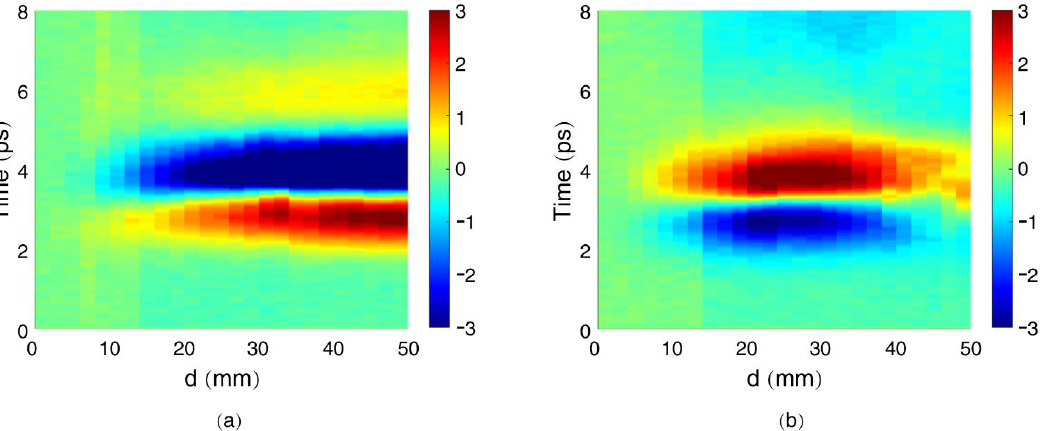
Figure 5. Measured THz radiation from a dc-biased filament with a longitudinal external electric field along the filament: ( a ) horizontally polarized component ( 𝐸 𝑥𝑙𝑜𝑤𝑒𝑟 ); ( b ) vertically polarized com- ponent ( 𝐸 𝑦𝑙𝑜𝑤𝑒𝑟